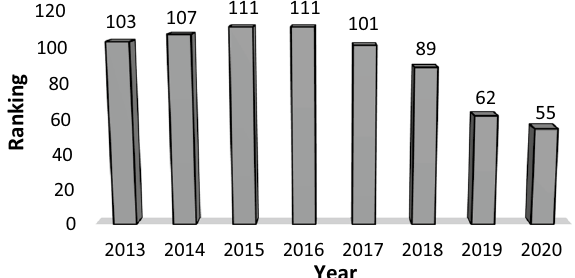
Fig. 11 Global ranking of Pakistan in terms of business environment (Global Innovation Index, 2019,